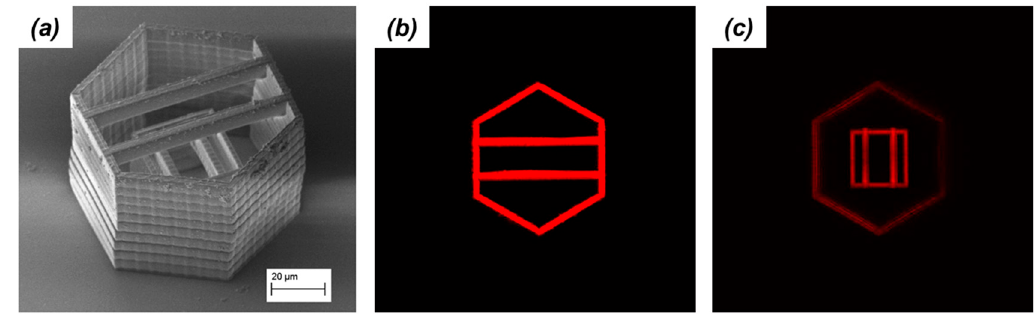
Figure 10. ( a ) SEM image of two TPP microstructures doped with Rhodamine B. The smaller structure was written inside the larger one and so difficult to observe (scale bar 20 µ m). Two-photon excited fluorescence (TPEF) microscopy images of the TPP microstructures recorded at different heights are shown in ( b , c ). They reveal two z -sections of the sample with no cross-talk.